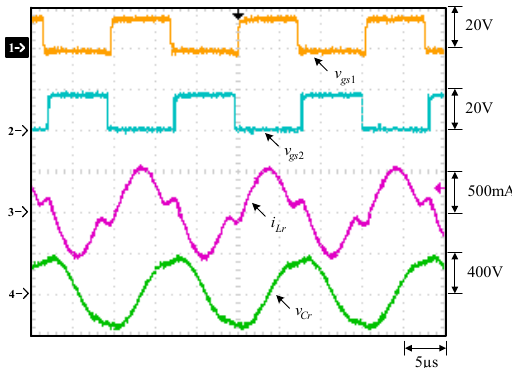
Figure 14. Waveforms at rated load: (1) v gs 1 ; (2) v gs ; (3) i Lr ; (4) v Cr .